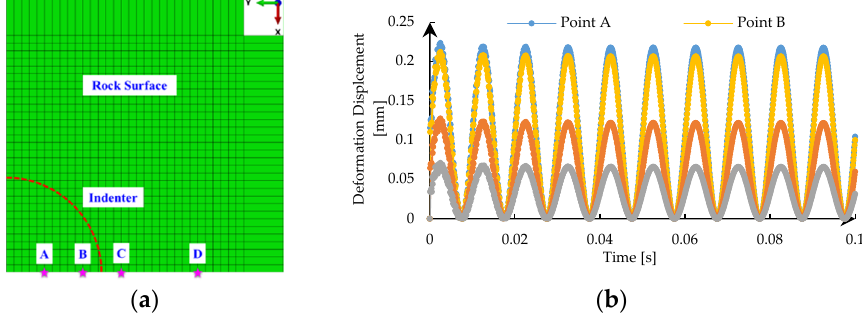
Figure 6. Numerical results showing deformation displacements of different positions on the surface of the rock for cylindrical indenter: ( a ) Top view of the rock surface. ( b ) The relationships of deformation displacement versus time of points A, B, C and D.